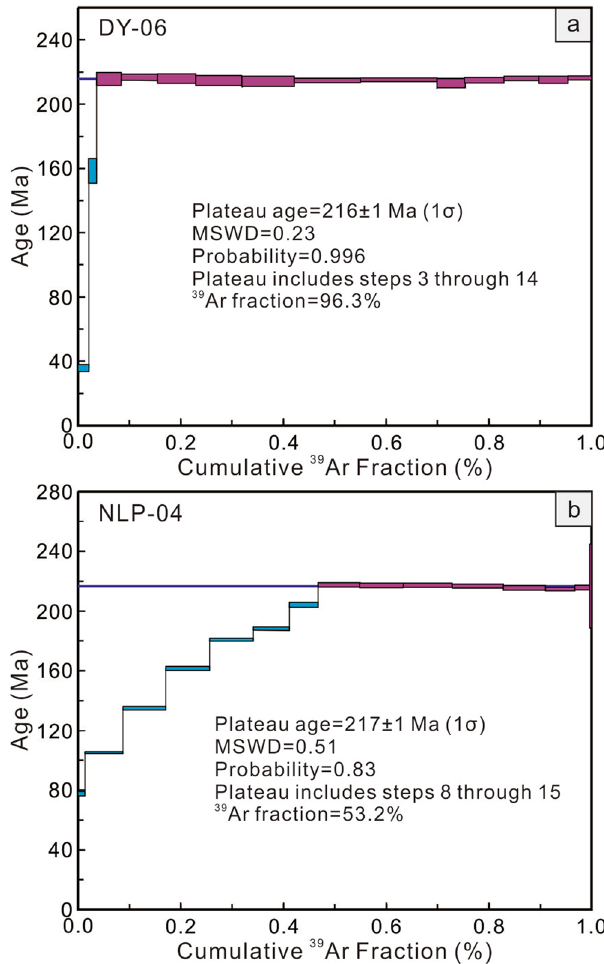
Figure 1. 40 Ar- 39 Ar plateau ages for phlogopite from the Danyang and Niulangpo